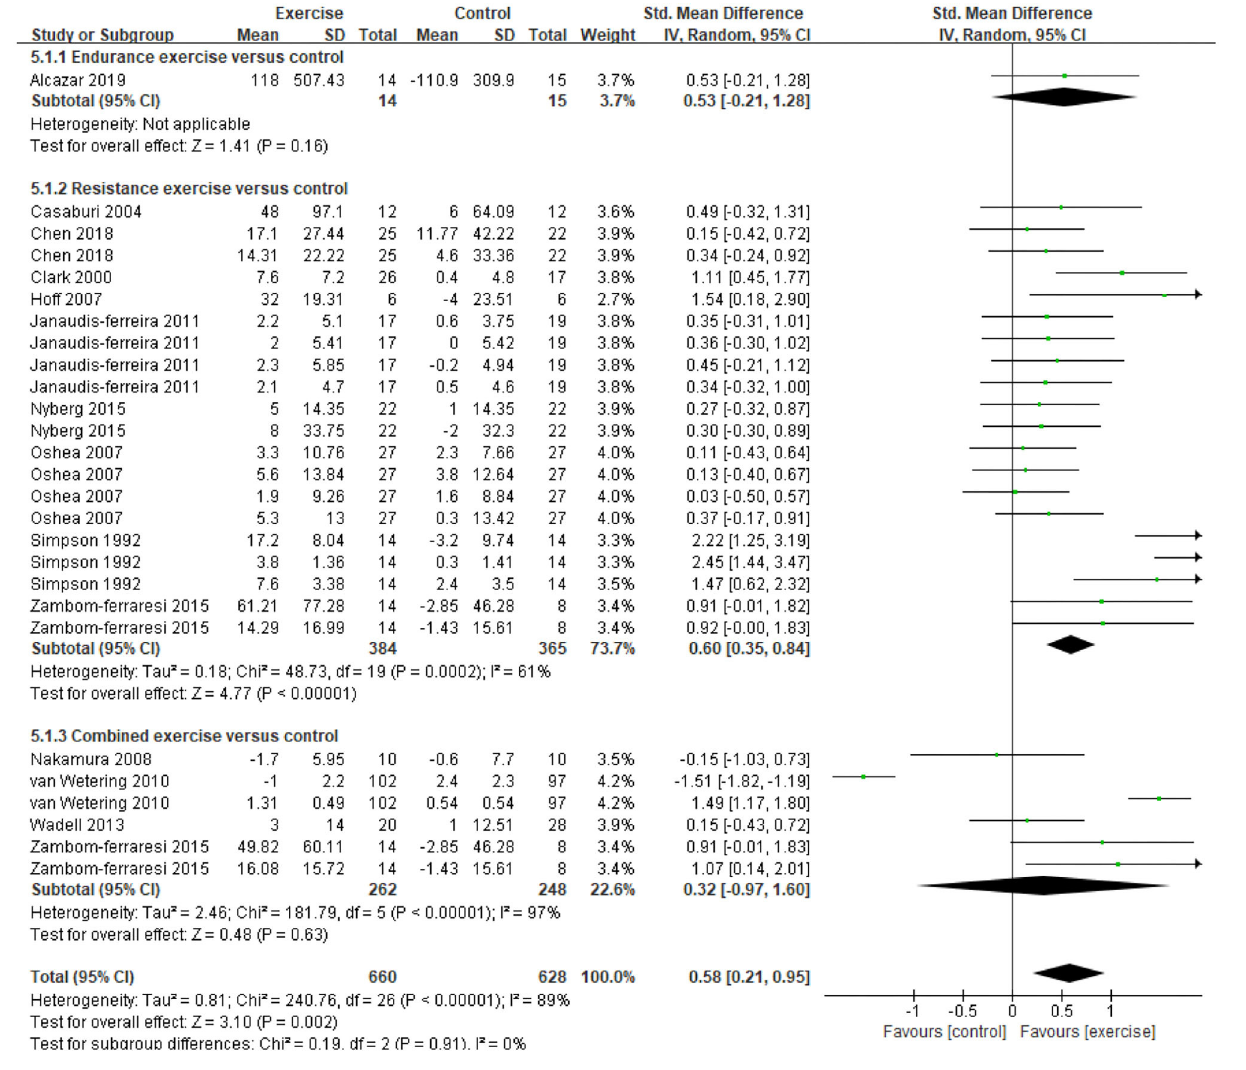
FIGURE 3 | Effects of three types of exercise on skeletal muscle strength in patients with COPD. CI, confidence interval; COPD, chronic obstructive pulmonary disease; SD, standard